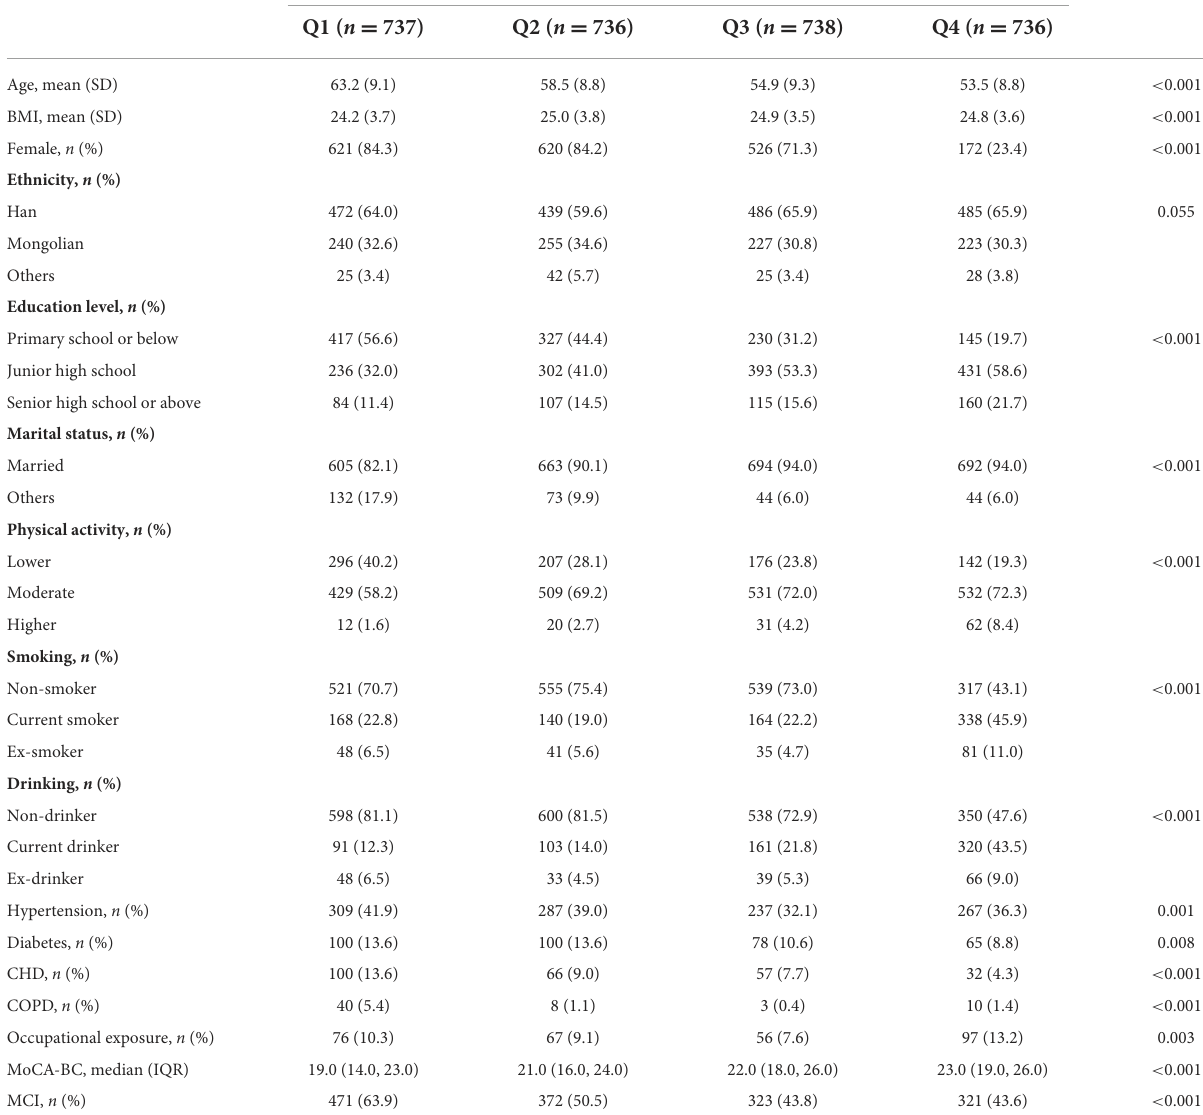
TABLE 1 Baseline characteristics of participants by quartiles of composite pulmonary